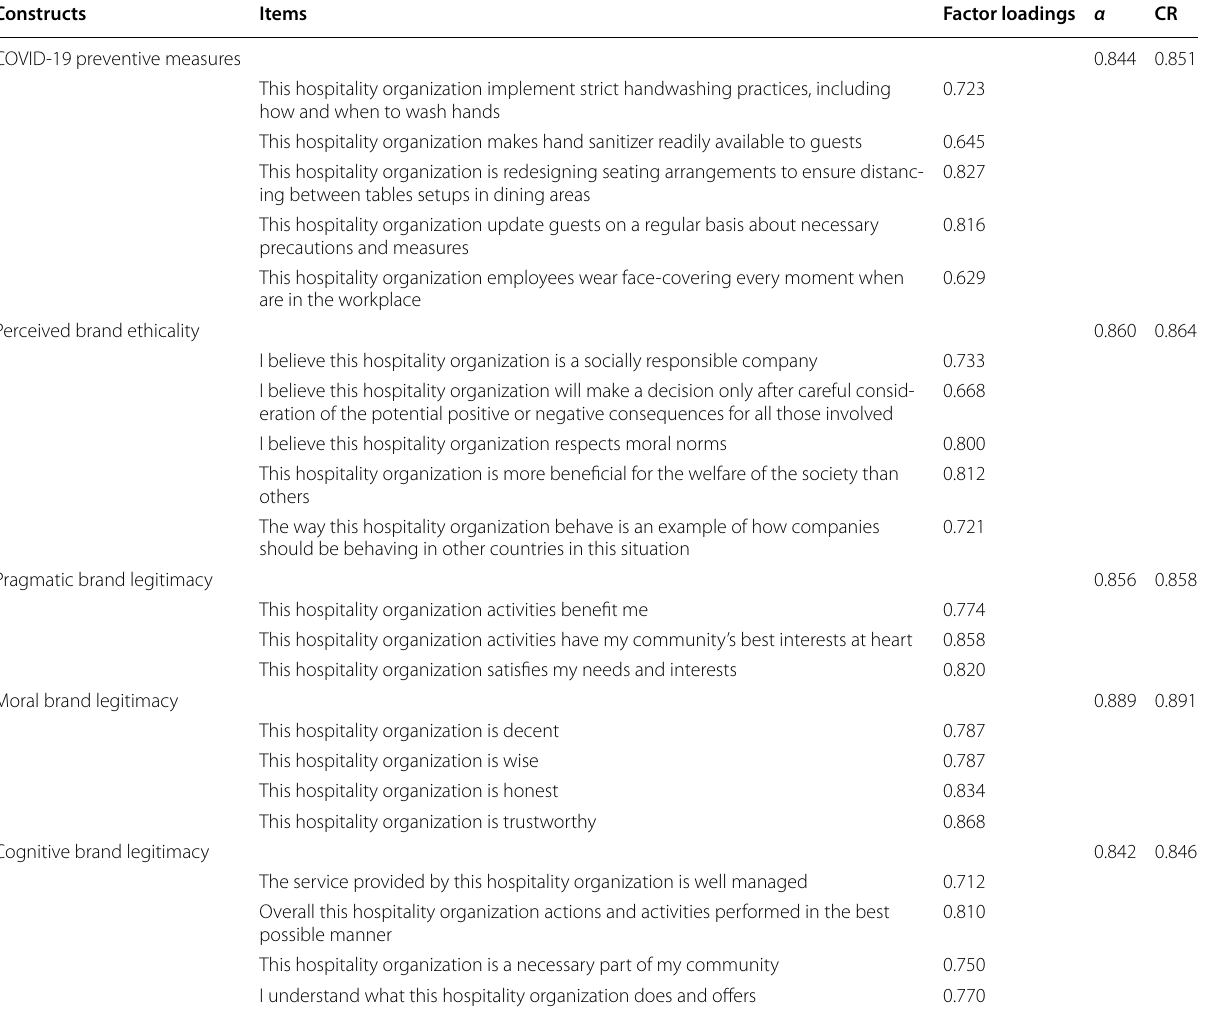
α Cronbach’s alpha, CR composite reliability